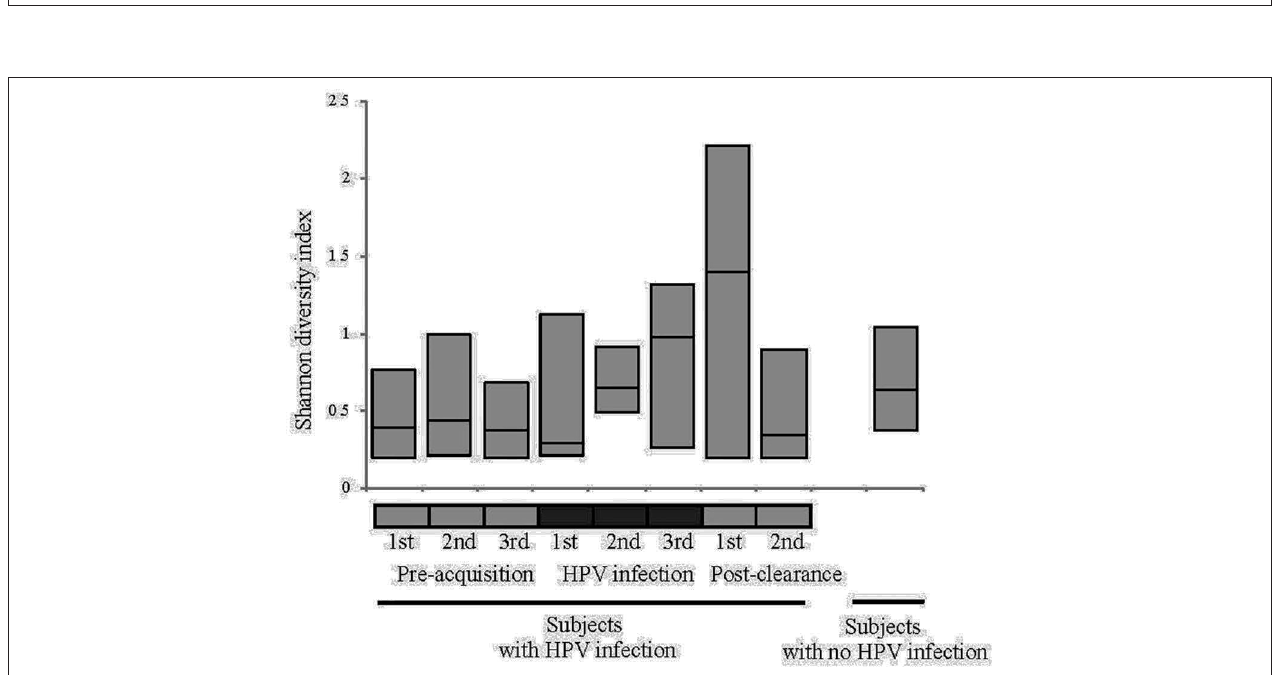
Frontiers in Cellular and Infection Microbiology | www.frontiersin.org